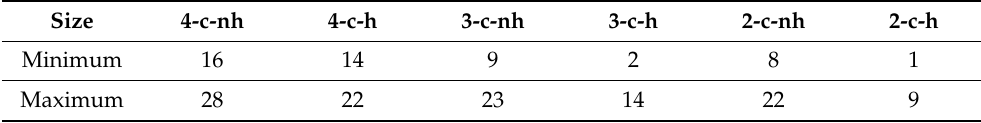
Table 4. Minimum and maximum size subsets for each dataset.